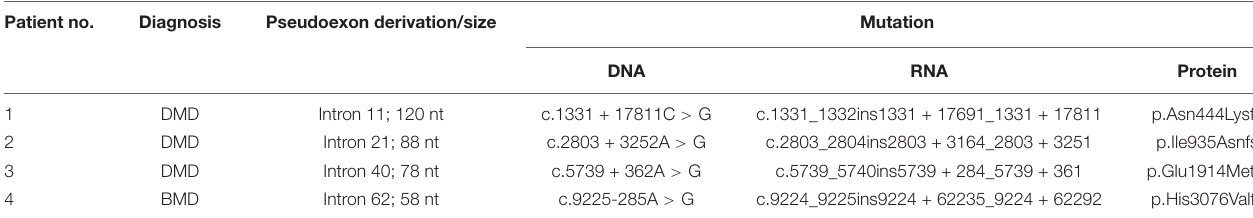
TABLE 2 | Pseudoexon insertion mutations in four patients. Patient